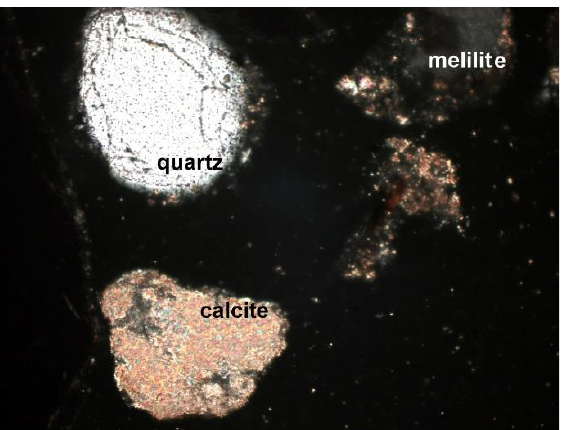
Figure 7. Grain of quartz, melilite, and carbonates (calcite) (SP2 sample), thin section, 2P, 100×, transmitted light.